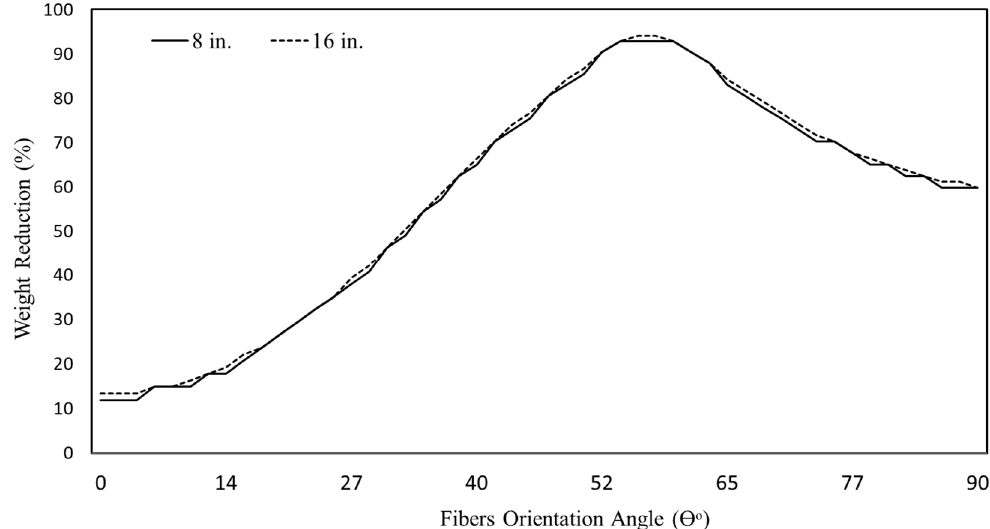
Figure 12. The weight reduction of 8” and 16” PVs made of IM7/977-3 compared to ones made of SST 316L for different fiber angles.